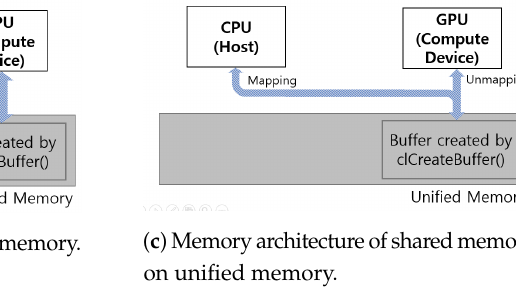
Figure 2. Memory architecture comparison of desktop platforms and mobile